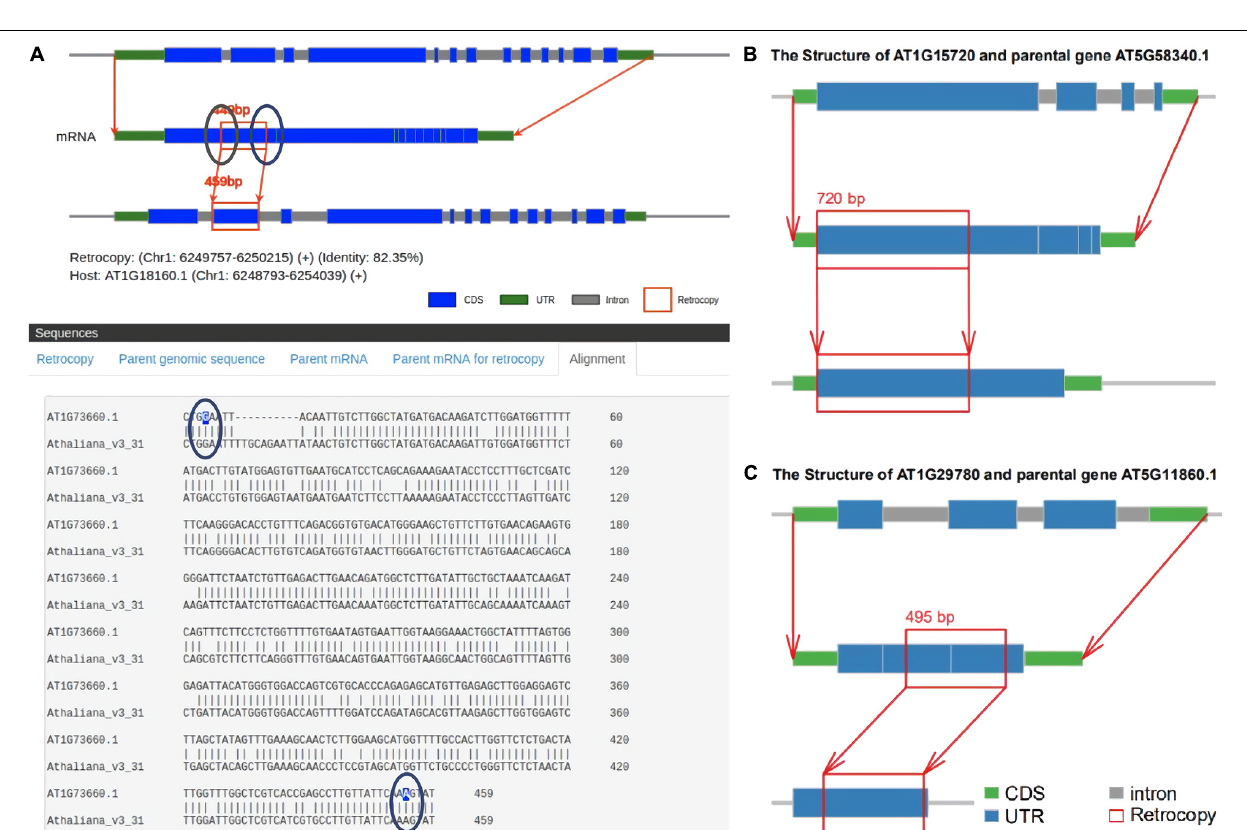
FIGURE 4 | False-positive retrocopies. (A) The sites of lost introns are located in the marginal area of the retrocopies in PlantRGDB. (B) The parental genes identified by Zhang do not lose any introns. (C) The parental genes identified by Abdelsamad lose only one intron.